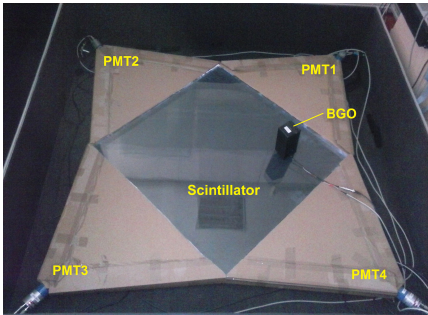
Figure 3. Main scintillator (100cm × 100cm × 5cm). Four PMTs inside its pyramidal guides gather the light from lateral sides of the scintillator. The BGO inside the little black box can be moved over the scintillator surface. The BGO and three PMTs work in coin- cidence; thus, only the muon trajectories crossing the BGO will be detected and the amplitude of PMTs pulses will carry position infor- mation. The BGO is used to calibrate the system. The whole system is located inside a closed dark chamber.